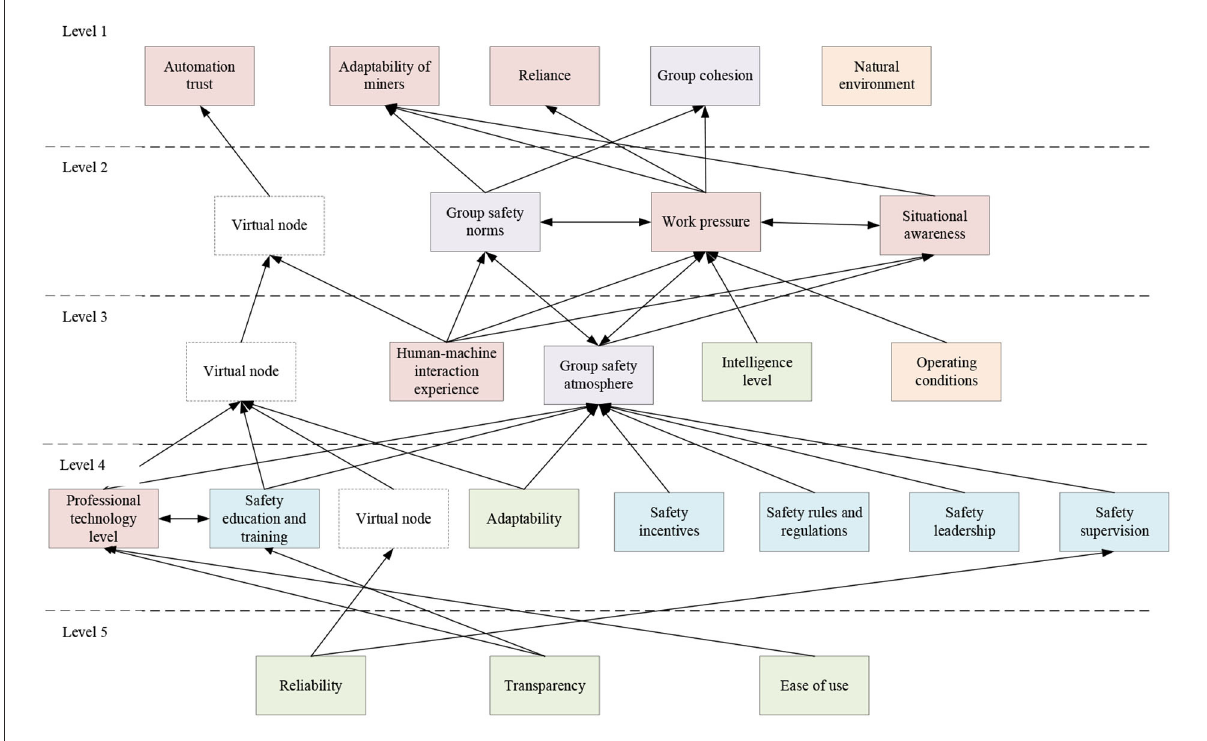
FIGURE4 Interpretation structure model of coal mine safety system.